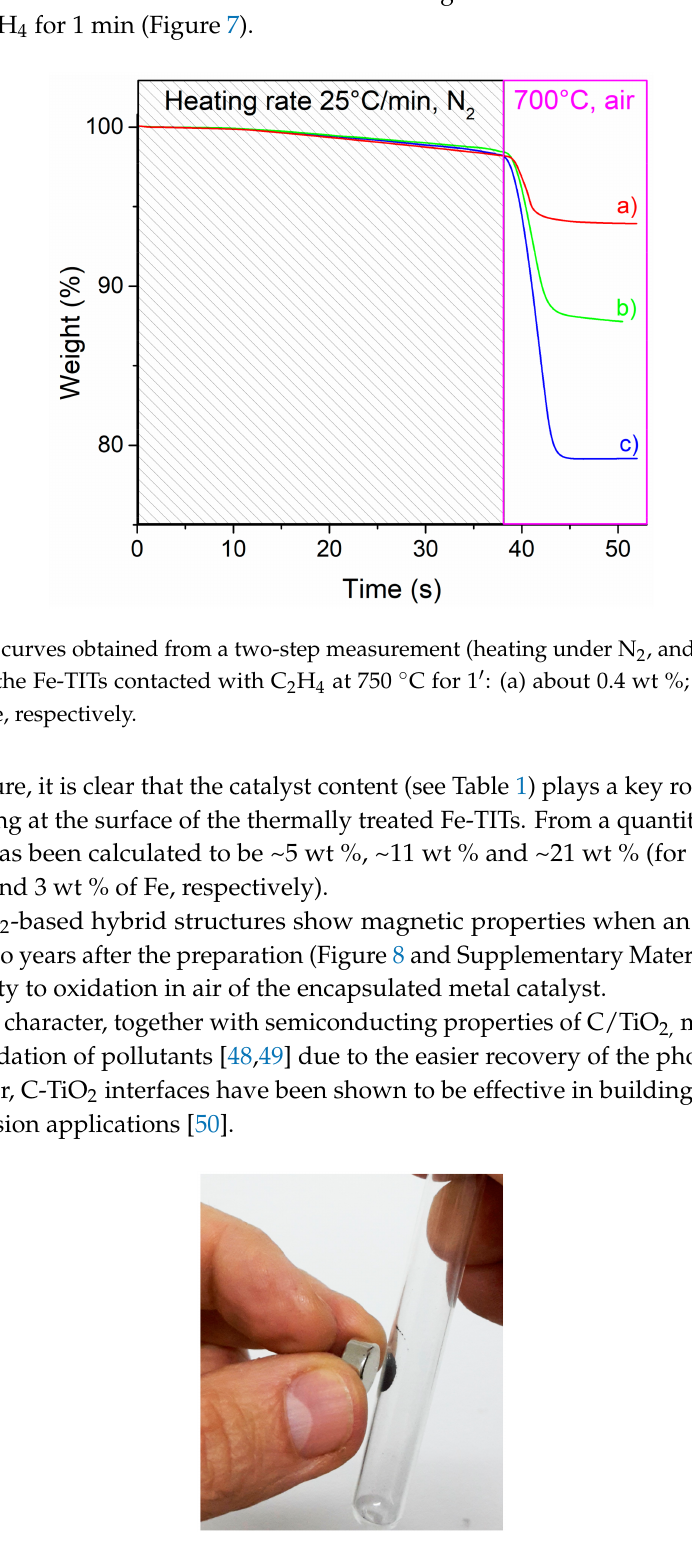
Figure 8. Picture showing the macroscopic magnetic properties of C/TiO 2 hybrid material coming from the titanate nanotubes ion-exchanged with 0.01 M Fe(NO 3 ) 3 solution and then thermally treated for 1’ at 750 ◦ C with C 2 H 4